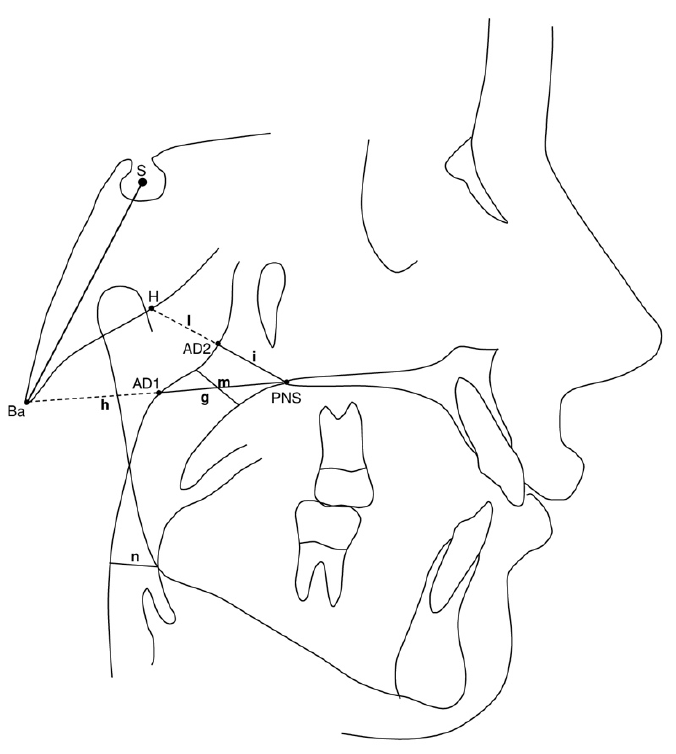
Figure 3. Cephalometric measurements for the analysis of airway dimensions.